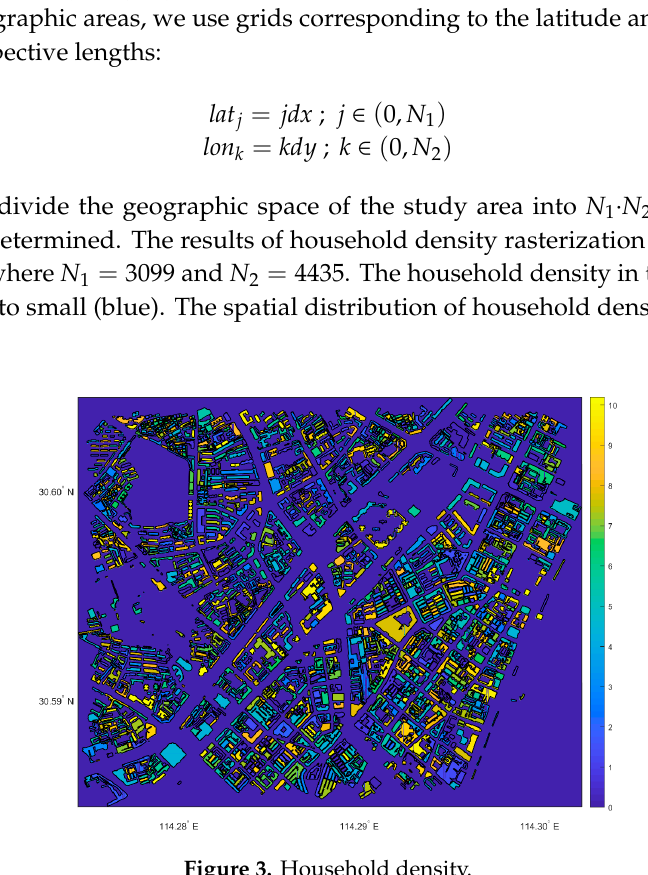
Figure 3. Household density.